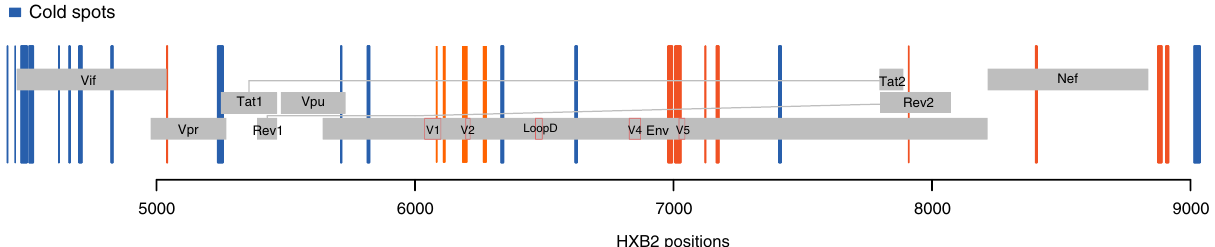
Fig. 6 Identi fi cation of recombination hotpots in HV-1 genome. Recombination hotspots are shown in dark orange and cold spots in blue across the 3 ′ half genome. Position numbering is relative to HXB2. Each line represents a position, and the thickness of the colored regions represents consecutive positions. The sequences from the last time point (day 432) in CH0654 were excluded from the analysis due to the initiation of ART at day